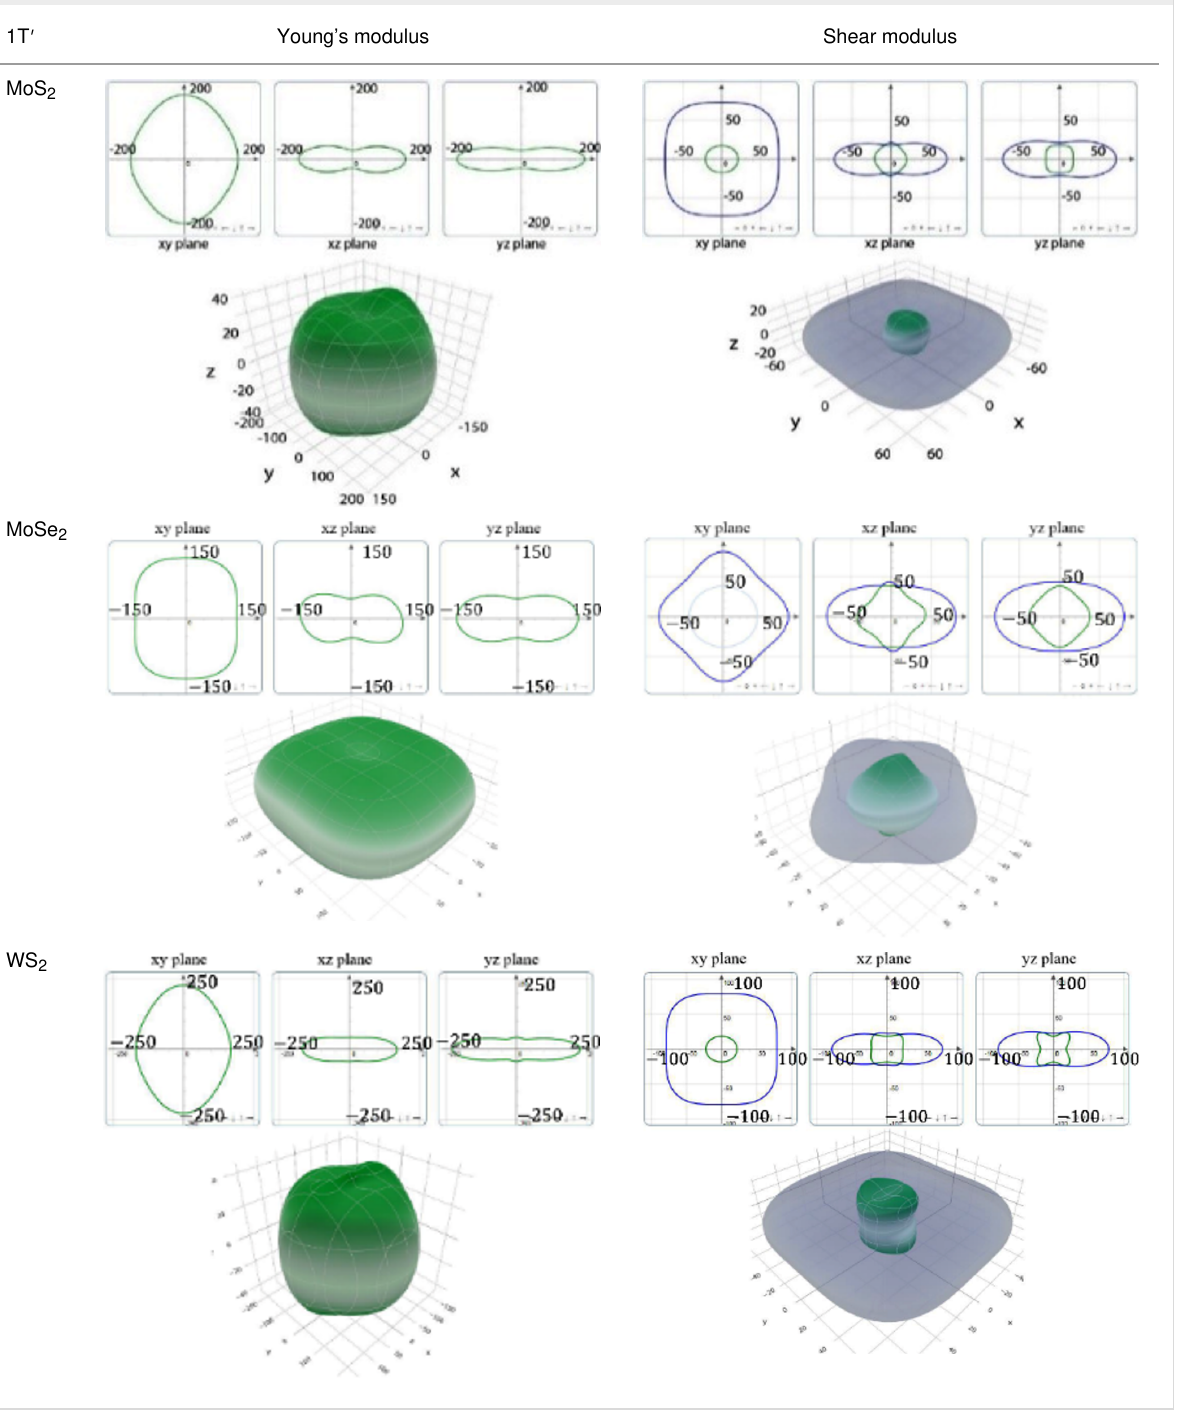
Table 2: 2D and 3D plots of the Young’s moduli and Shear modulie of 1T ′ MoS 2 , MoSe 2 , WS 2 and WSe 2 . 1T